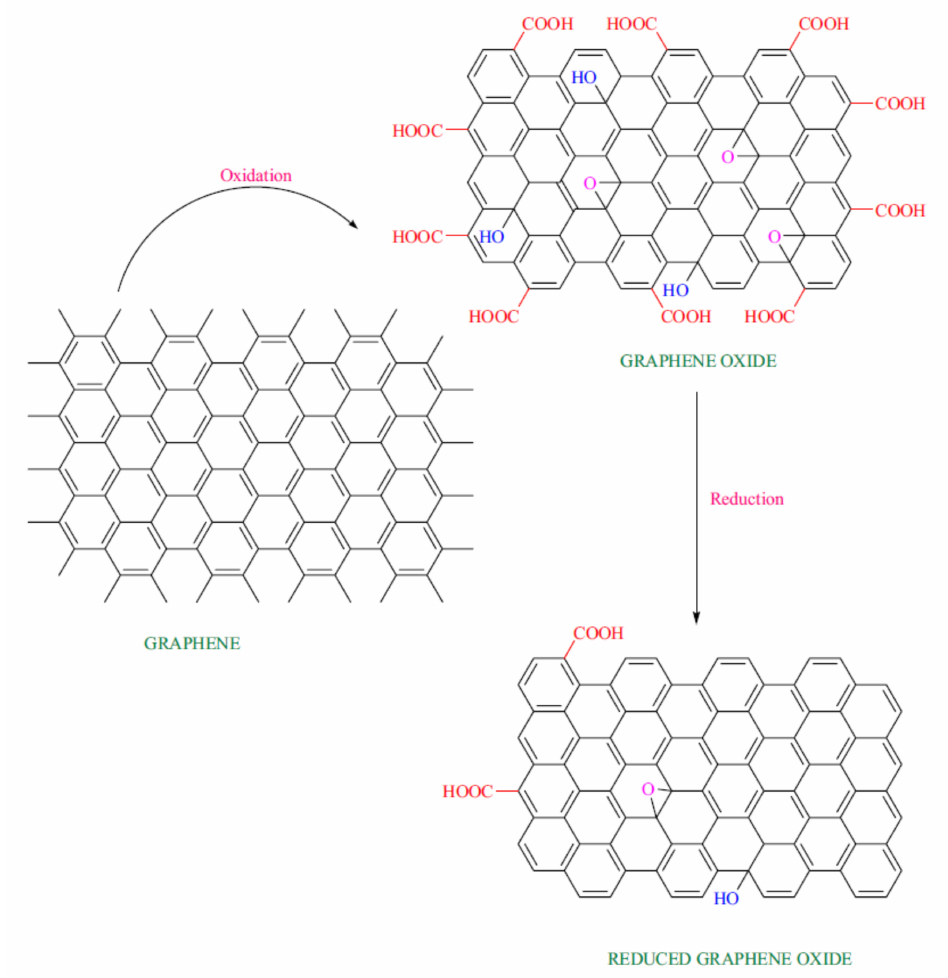
Figure 8. Overview of various structures of GNs and the illustration of covalent/non-covalent functionalization of GNs. Reprinted with permission from